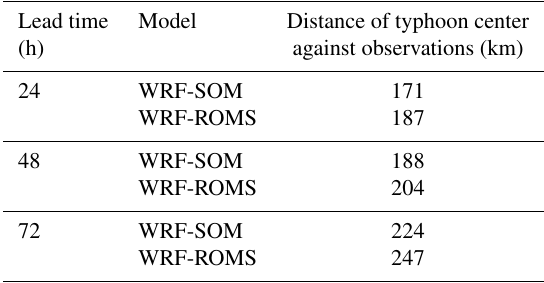
Table 1. Typhoon track errors in different simulation periods com- pared with observations from